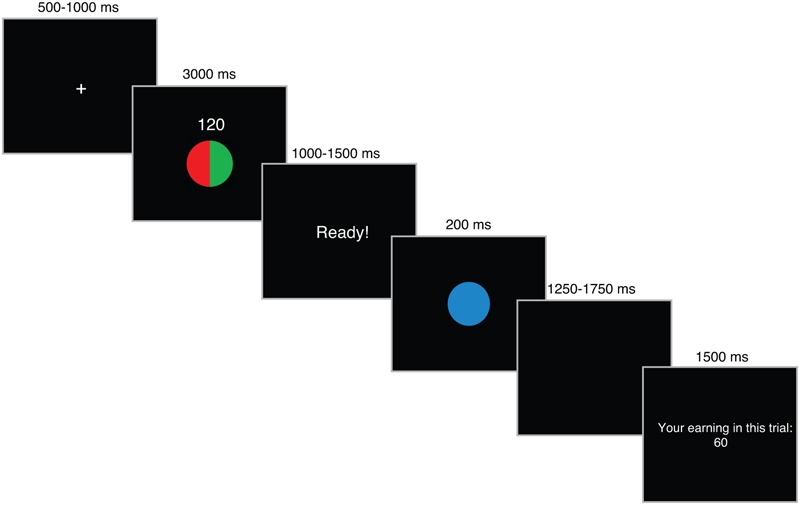
The trial structure for Speed-Rewarded Go-NoGo task.